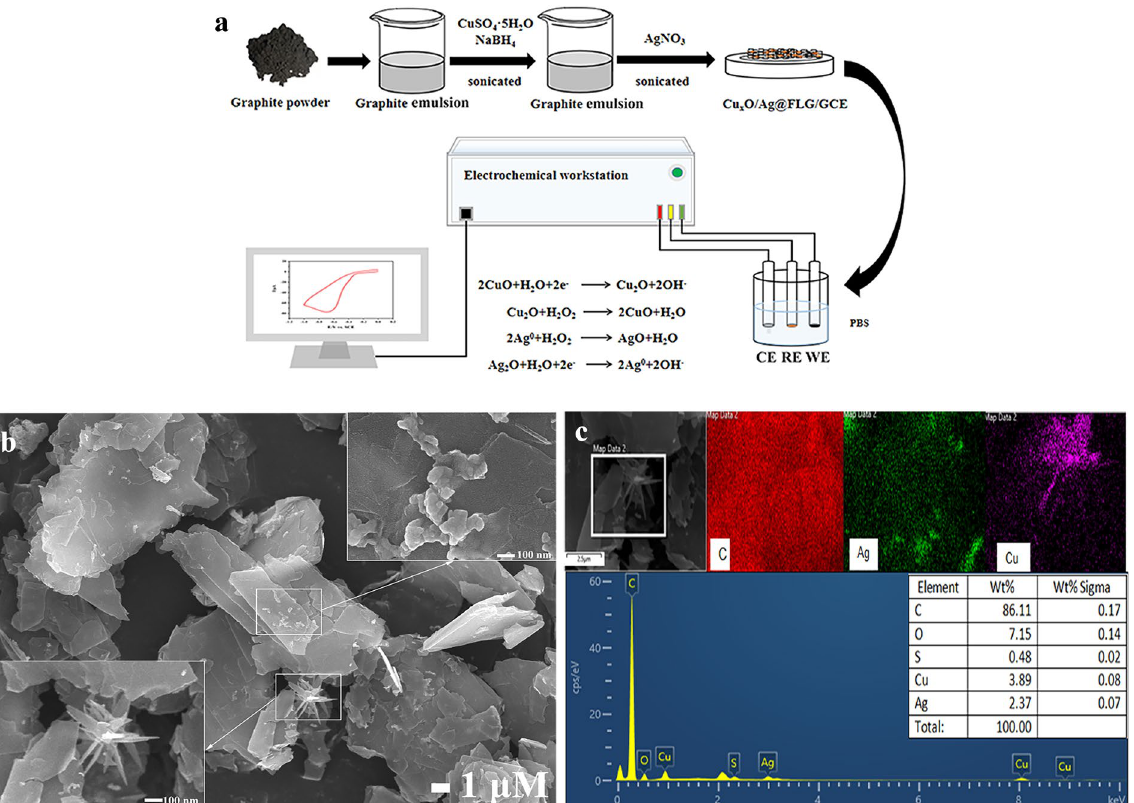
Figure 1. ( a ) preparation of Cu x O/Ag@FLG and mechanism of detecting H 2 O 2 . ( b )SEM images and ( c ) EDS images of